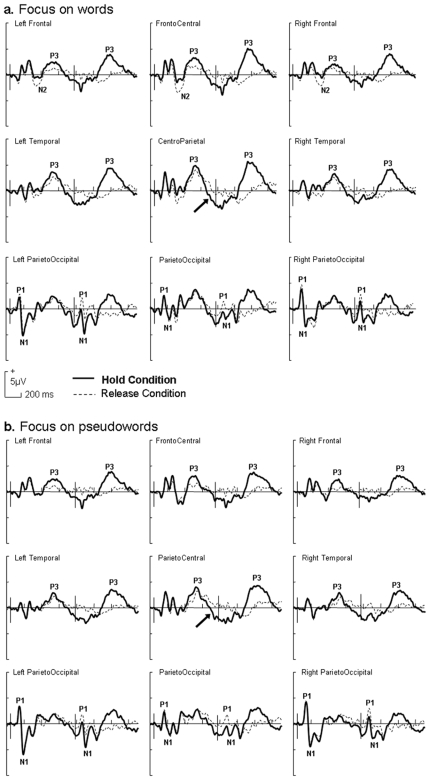
ERP results, general overview.Event-related potential results over nine major scalp regions (Left Frontal, electrodes F3, F5, FC3, FC5, FT7; FrontoCentral, F1, F2, FC1, FCz, FC2; Right Frontal, F4, F6, FC4, FC6, FT8; Left Temporal, C3, C5, CP3, CP5, TP7; ParietoCentral, C1, Cz, C2, CP1, CP2; Right Temporal, C4, C6, CP4, CP6, TP8; Left ParietoOccipital, P3, P5, PO3, PO7, O1; ParietoOccipital, P1, Pz, P2, POz, Oz; Right ParietoOccipital, P4, P6, PO4, PO8, O2). a. Lexical categorization focus on word pairs. b. Lexical categorization focus on pseudoword pairs. ERPs for hold (full line) and release (dotted line) sustained attention conditions. Vertical bars on graphs indicate the onset of the first and second item of a pair.